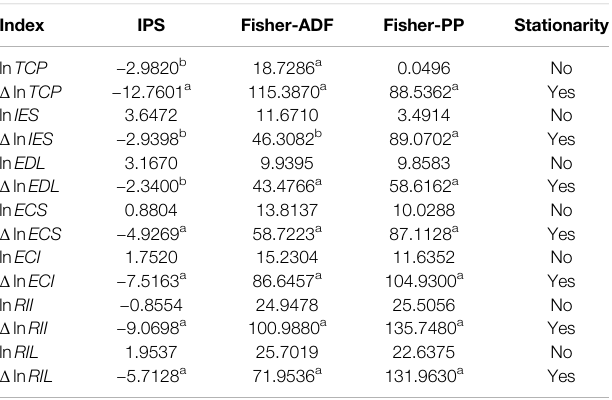
TABLE 2 | The results of the unit root test.